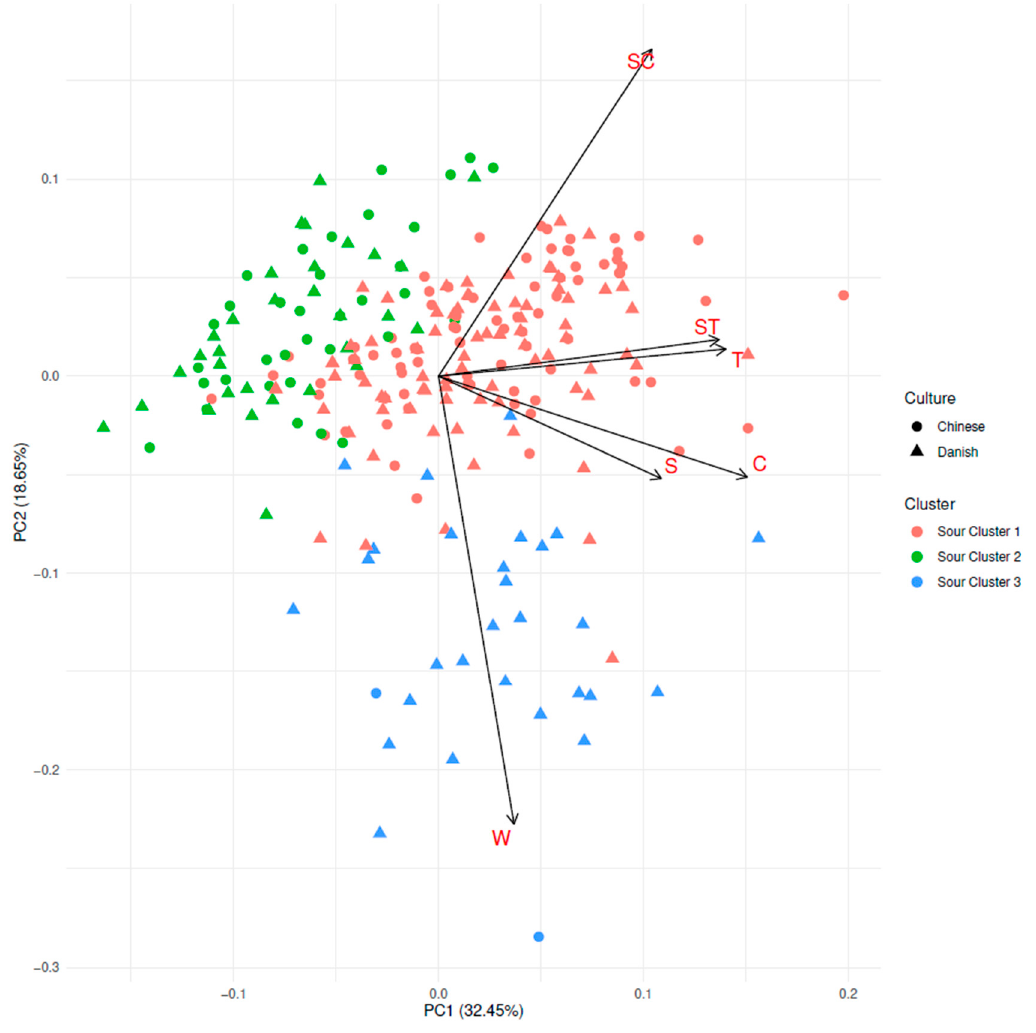
Figure 5. PCA biplot showing consumers sourness ratings. Both their relation to clusters and culture are visualized. Samples are Water (W), Citric acid (C), Tartaric acid (T), Sucrose (S), Sucrose and Citric acid (SC), and Sucrose and Tartaric acid (ST).